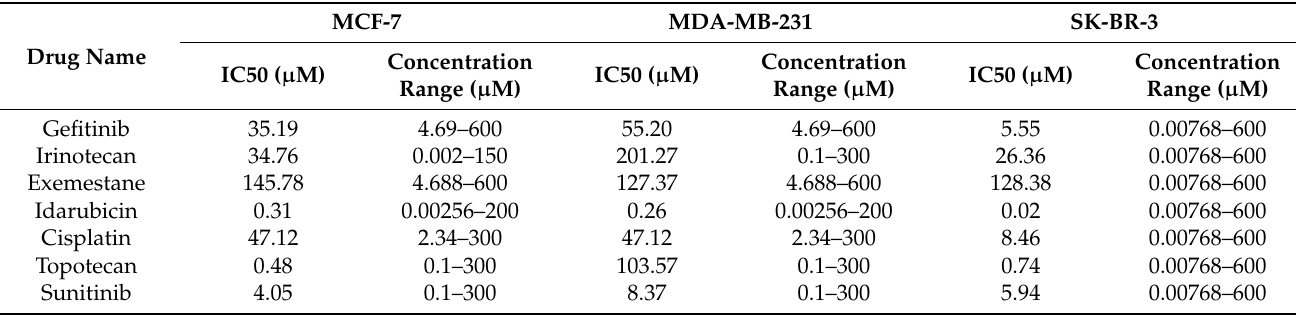
Table 7. Single drug IC50 value determination.